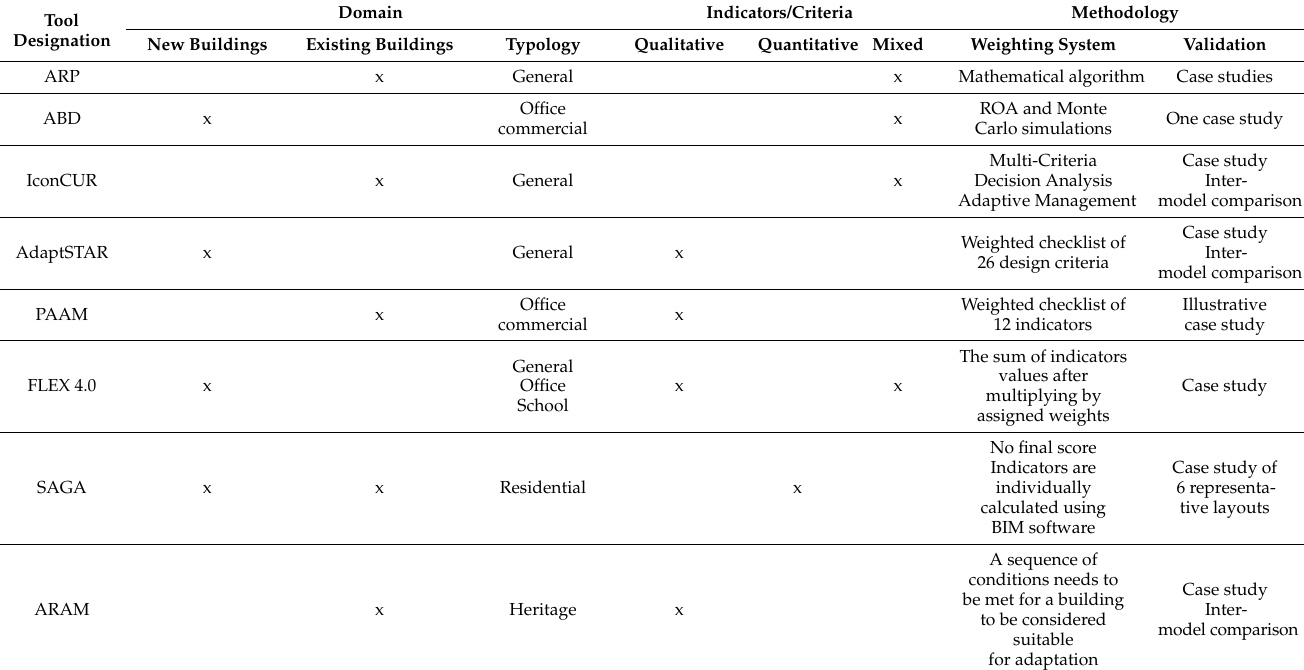
Table 2. Comparative analysis of existing adaptability models and tools (domain, indicator type and